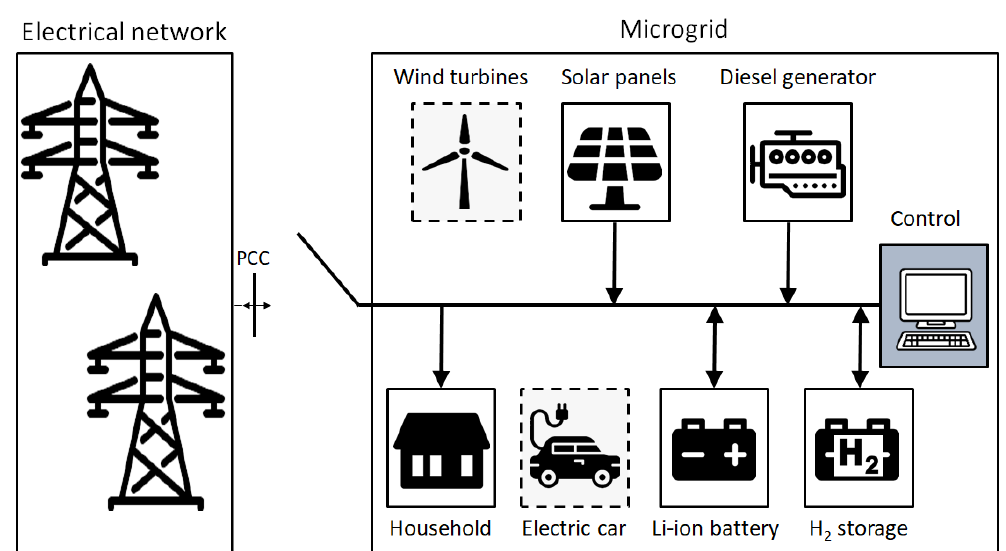
Figure 1. Schematic example of a